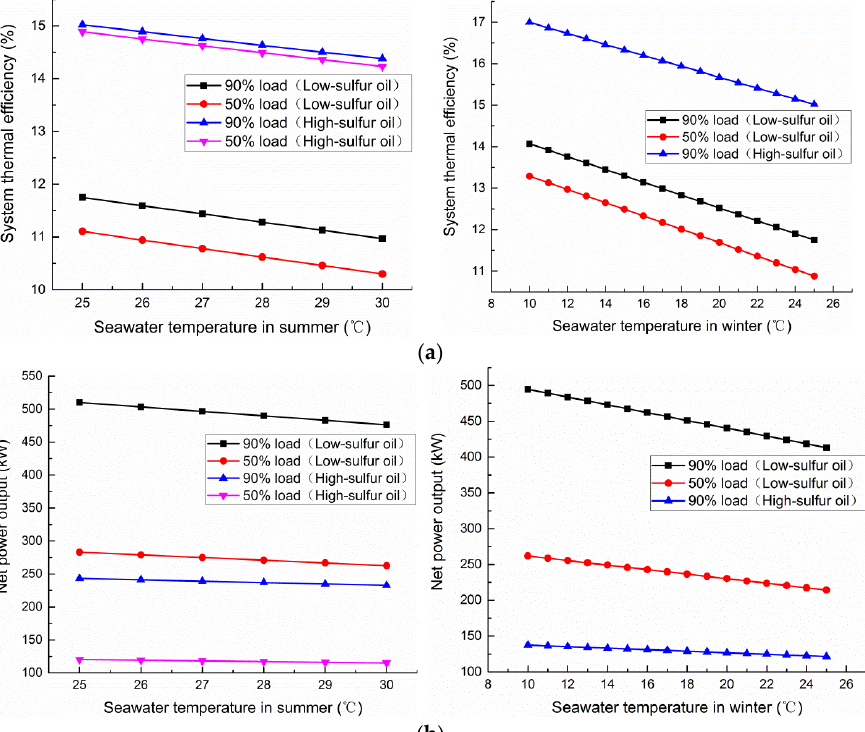
Figure 5. Variations in performance with seawater temperature for the exhaust gas side ORC sub ‐ system; ( a ) Thermal efficiency vs. seawater temperature in summer and winter; ( b ) Net power output vs. seawater temperature in summer and winter